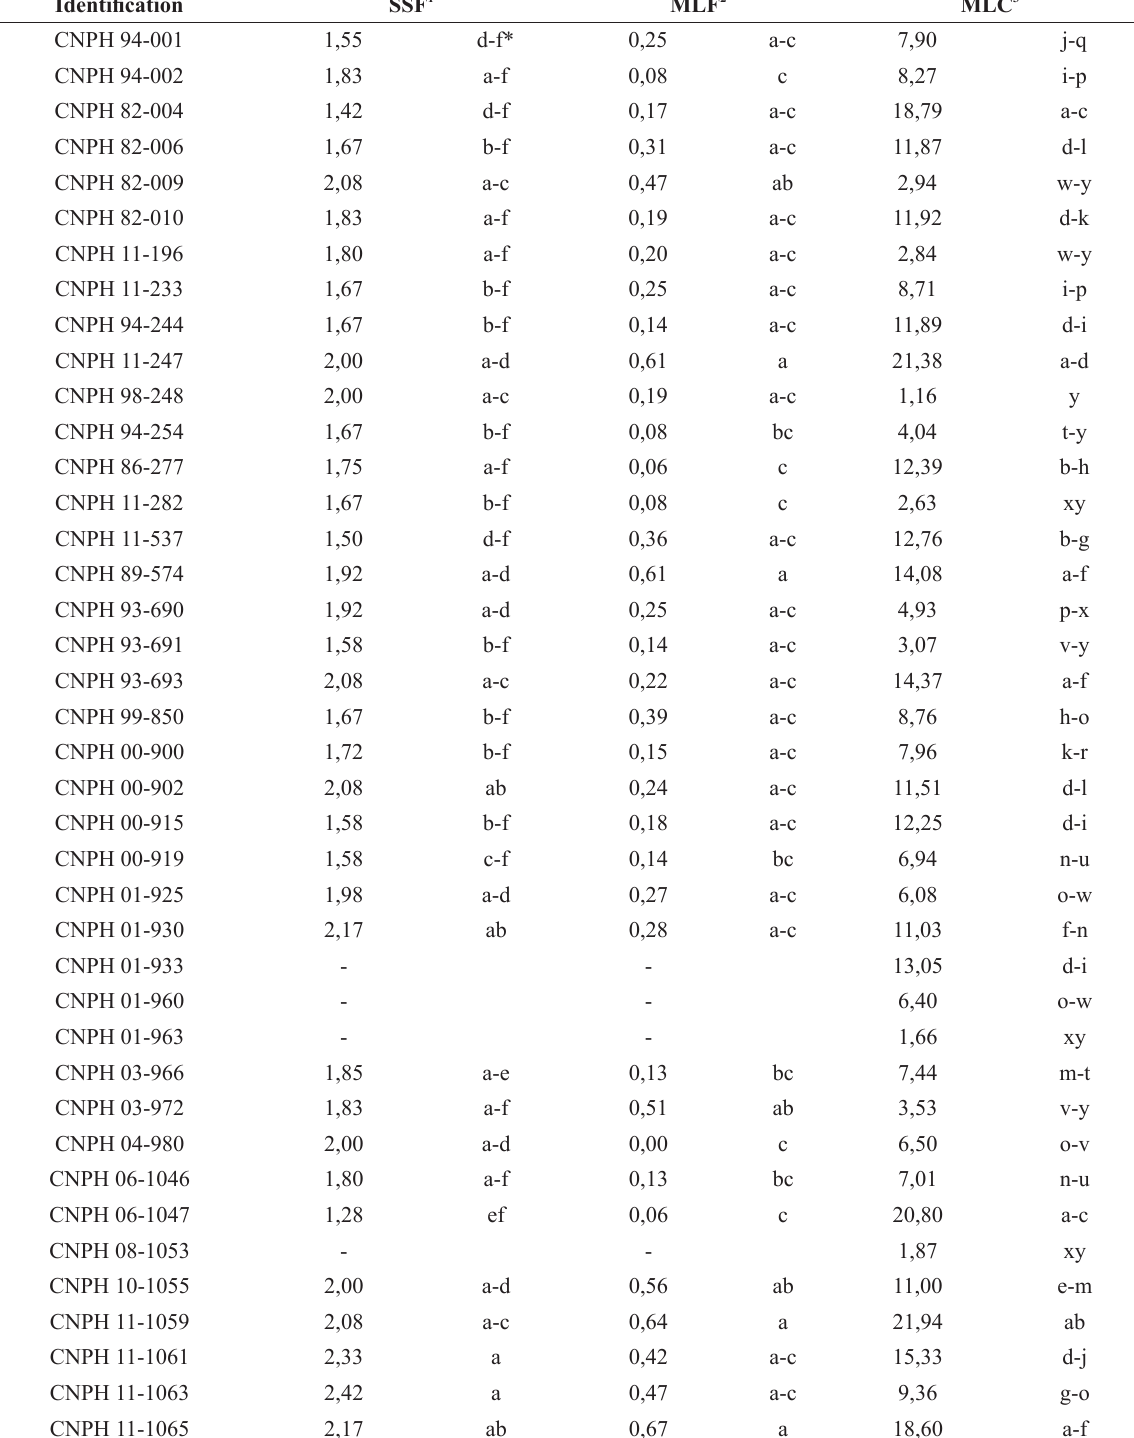
Mean values of variables of the evaluation of melon germplasm for resistance to vegetable leafminer with and with no choice, Fortaleza, CE, Brazil,